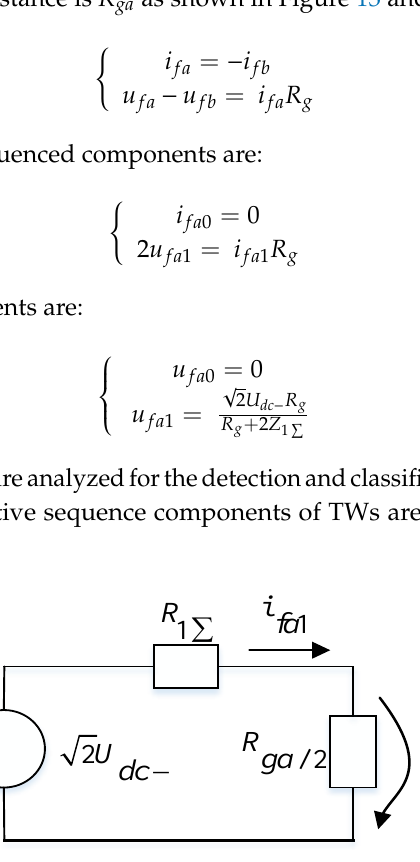
Figure 13. Sequence network connection for pole-pole fault.